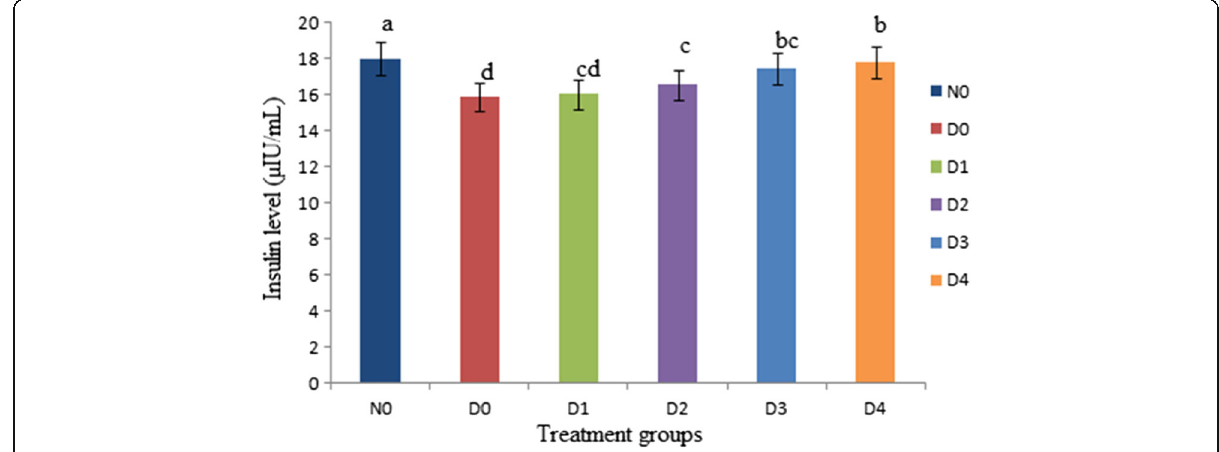
Fig. 4 Effect of Stevia aqueous extract on insulin levels of different groups of rats. Results are expressed as concentration of insulin levels of diabetic and non-diabetic rats (mean ± standard deviation (SD). n = 10). a, b, c, d represent significant difference ( P < 0.05) in insulin levels treatment wise. The insulin levels of diabetic rats (D 1 , D 2 , D 3 and D 4 ) received stevia aqueous extract in different concentrations (200, 300, 400 and 500 ppm) respectively significantly ( P < 0.05) increased as compared diabetic (D 0 ) control groups and near to N